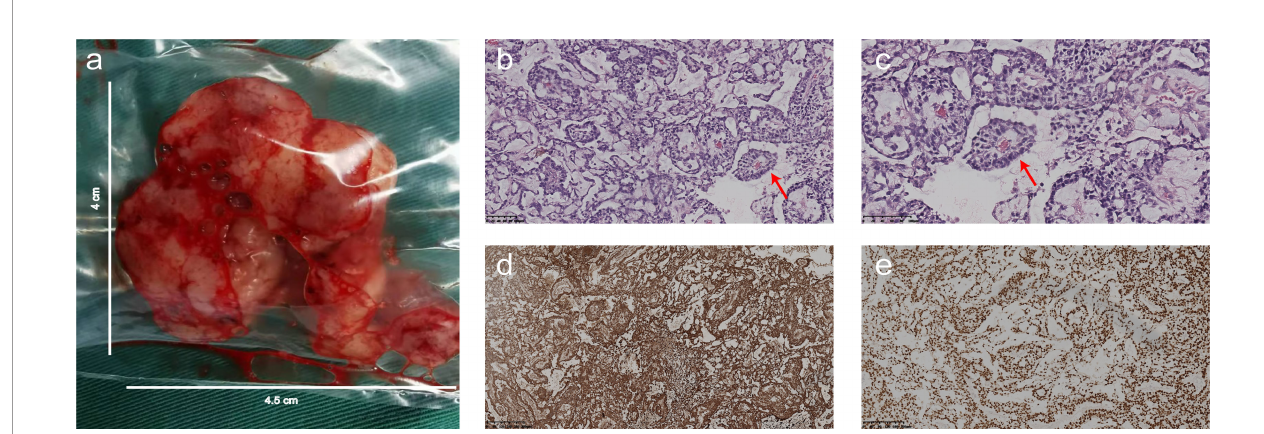
FIGURE 2 | The operative fi ndings and histopathology. (A) The tumor was located in the left cerebellar hemisphere and measured 4.5 cm× 4 cm. (B, C) Photomicrograph of hematoxylin and eosin staining showed that malignant tumor cells grew around the blood vessels or cavity, with typical Schiller-Duval bodies (red arrow). (D) Photomicrograph of immunohistochemical staining revealed that the majority of the tumor cells were strongly positive for alpha-fetoprotein (AFP) in the cytoplasm. (E) Photomicrograph of immunohistochemical staining suggested a positive reaction for Sal-like protein 4 (SALL-4) in the nucleus of the tumor cells. [Original magni fi cations: (B, D, E) 100×; (C)